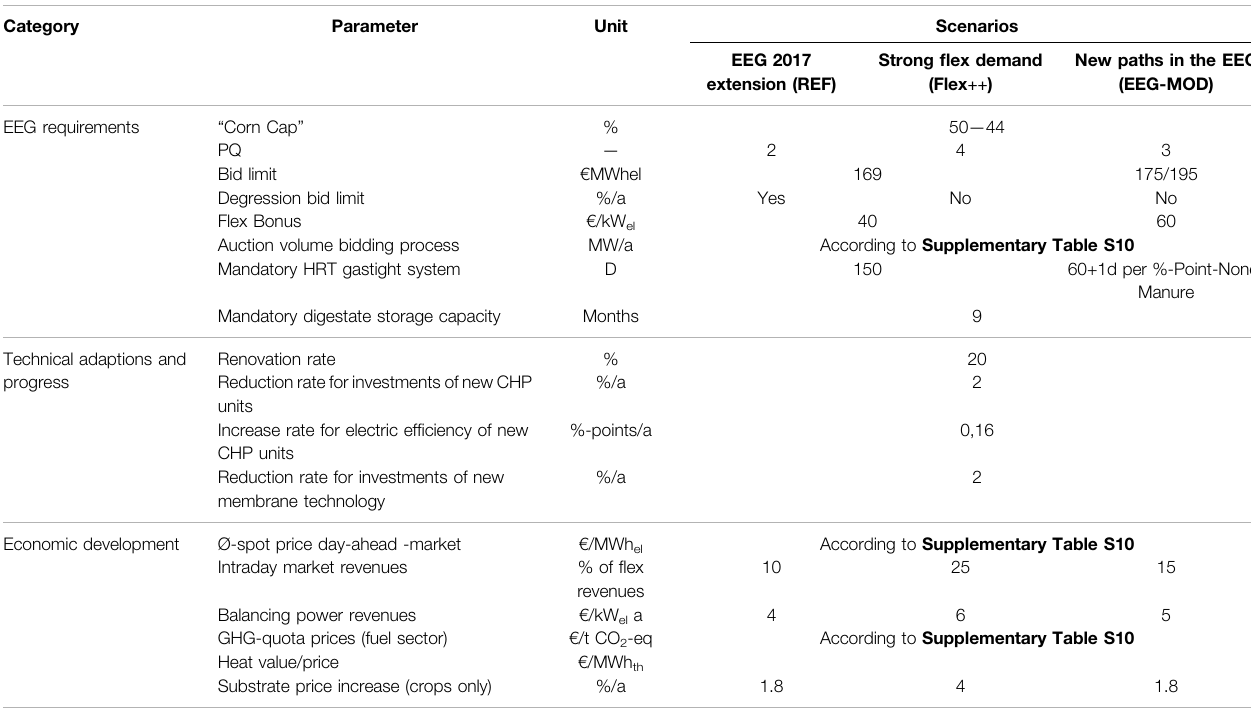
TABLE 6 | Scenario framework